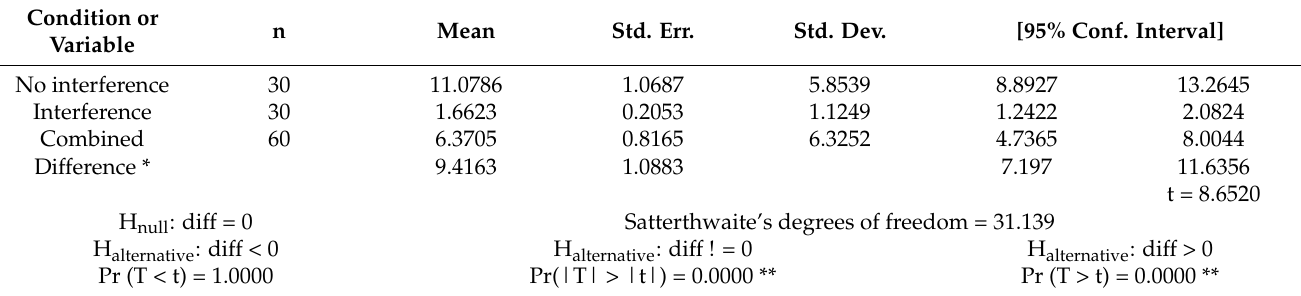
Table 6. Comparison of download throughput between the control and interference scenarios based on a t test.